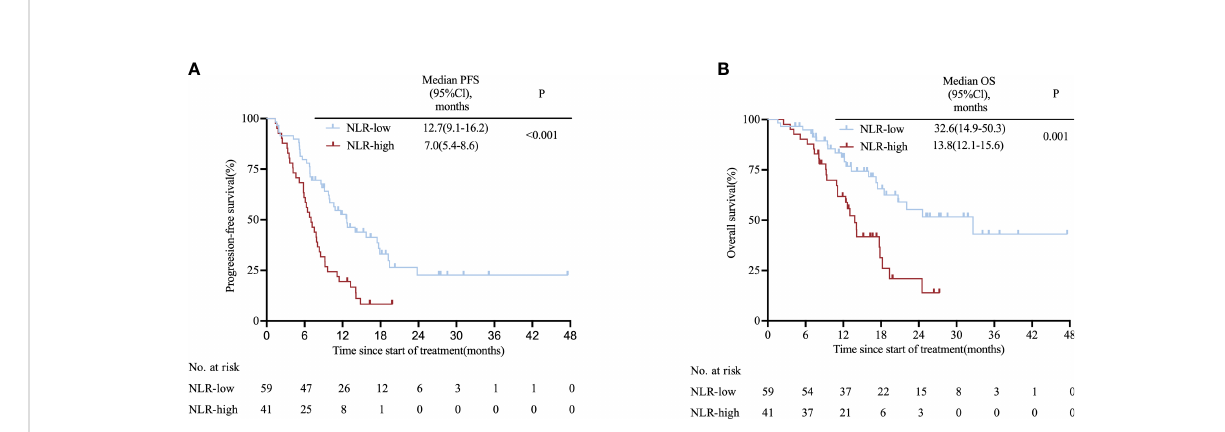
FIGURE 3 Kaplan-Meier survival curves in the pooled cohort strati fi ed by NLR for (A) PFS for NLR cut-off and (B) OS for NLR cut-off. CI , con fi dence interval ; NLR , neutrophil-to-lymphocyte ratio ; OS , overall survival ; PFS , progression-free survival.